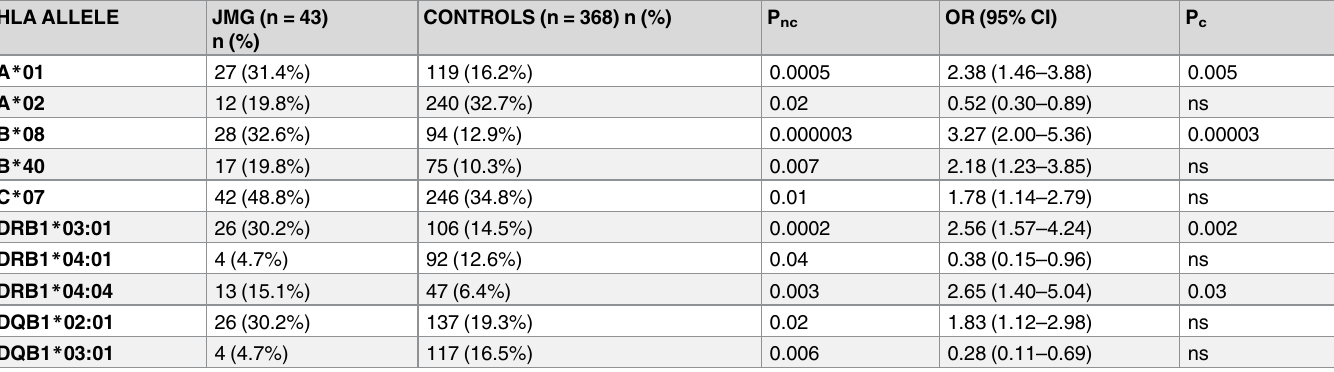
Odds Ratio (OR) and 95% confidence interval (CI) are shown for uncorrected P values (P nc ). P-values corrected for the number of tested alleles at each locus